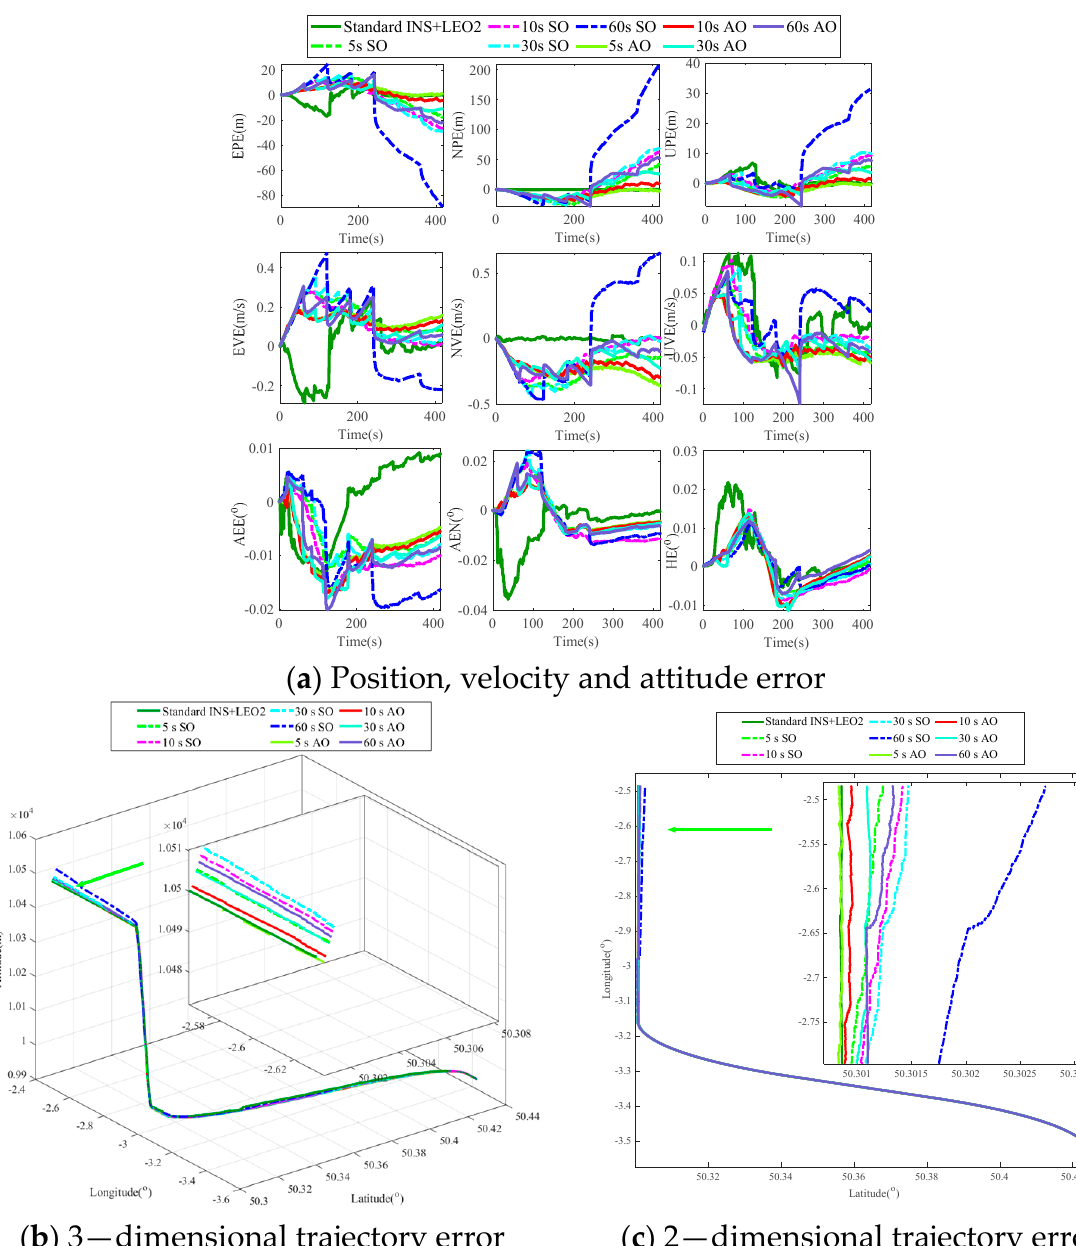
Figure 6. Navigation and positioning comparison curve of the INS+LEO2-satellite alternate switching ranging algorithm in the same orbit and adjacent orbits.